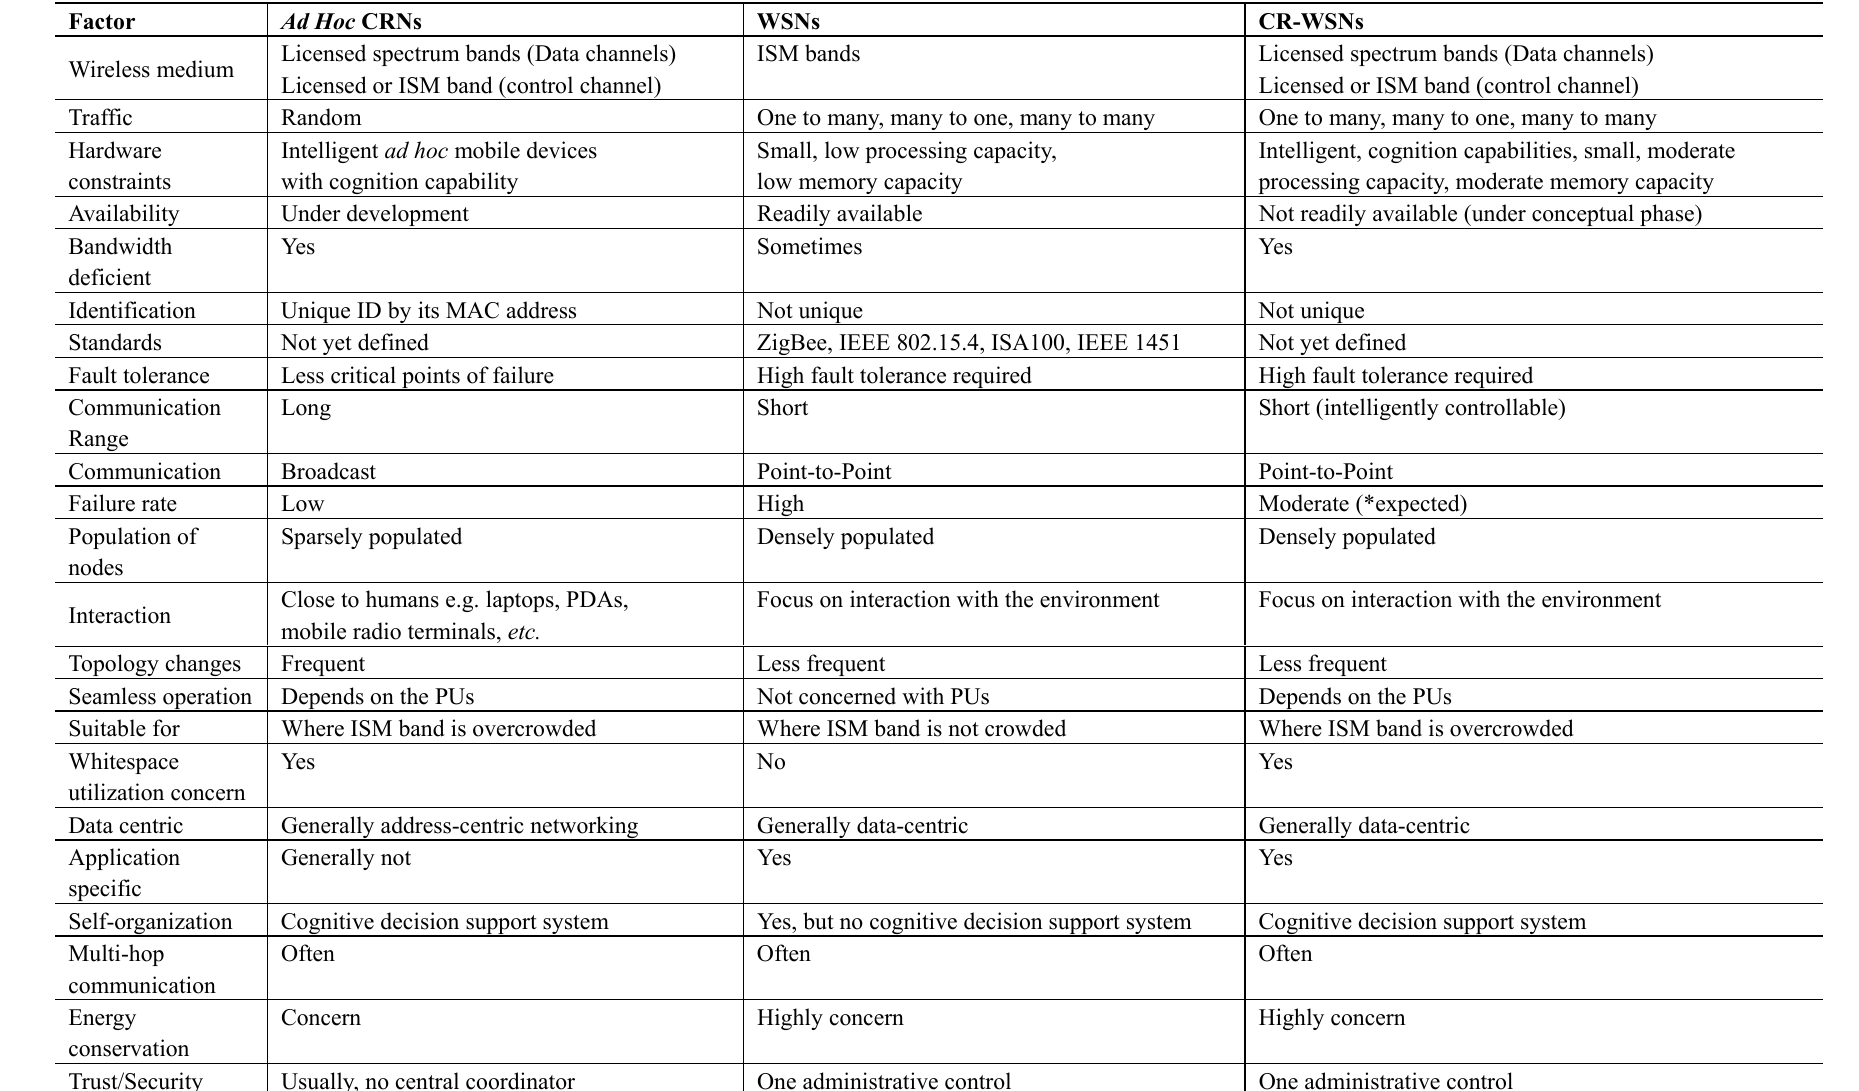
Table 3. Comparison of ad hoc CRNs, WSNs and